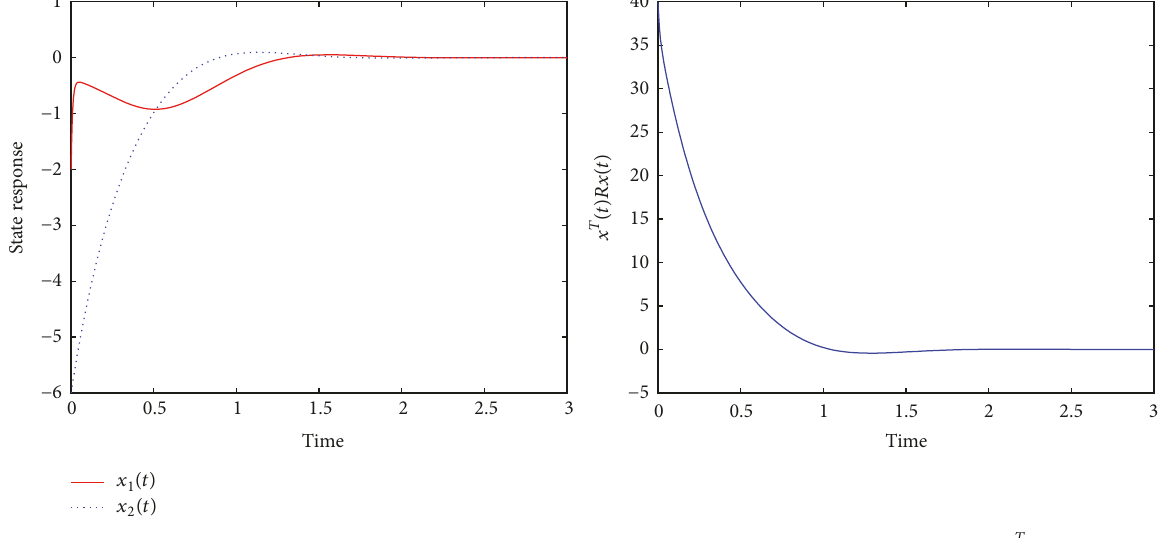
Figure 4: The state responses of polynomial fuzzy system (52) for the initial point 𝑥(0) = [−2 −6]